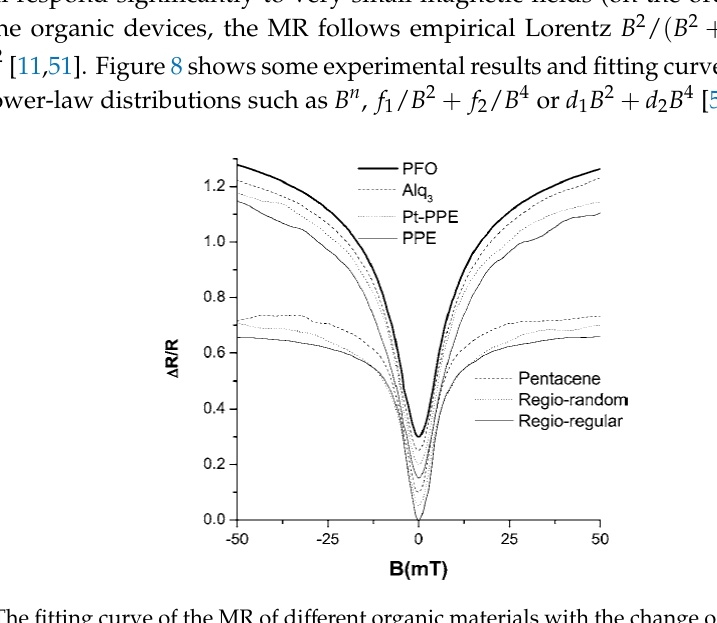
Figure 9. Schematic diagram of the experimental device corresponding to the magnetic field effect of organic devices by Mermer et al. [11] with the permission of Physical Review B. In 1996, Frankevich et al. experimentally found that the photocurrent in the polymer poly(2,5- diheptyloxy-p-phenylene vinylene) (HO-PPV) device increases after applying a magnetic field [54]. In 2003, Kalinowski et al. studied light-emitting device of small molecules Alq 3 , and they found that the light emitting efficiency of the device is increased by 5% as the magnetic field from 0 to 300mT [55]. Subsequently, Mermer et al. discovered MR in polymer poly(9,9-dioctylfluorenyl-2,7-diyl) (PFO) devices. At room temperature, the MR of the device reaches 10% at 100mT [31,56]. Figure 10 shows the MR curve in the ITO/PFO ( ≈ 60 nm)/Ca device at 200 K, and it found that the MR was negative at low voltage, but it becomes a positive value at high voltage.